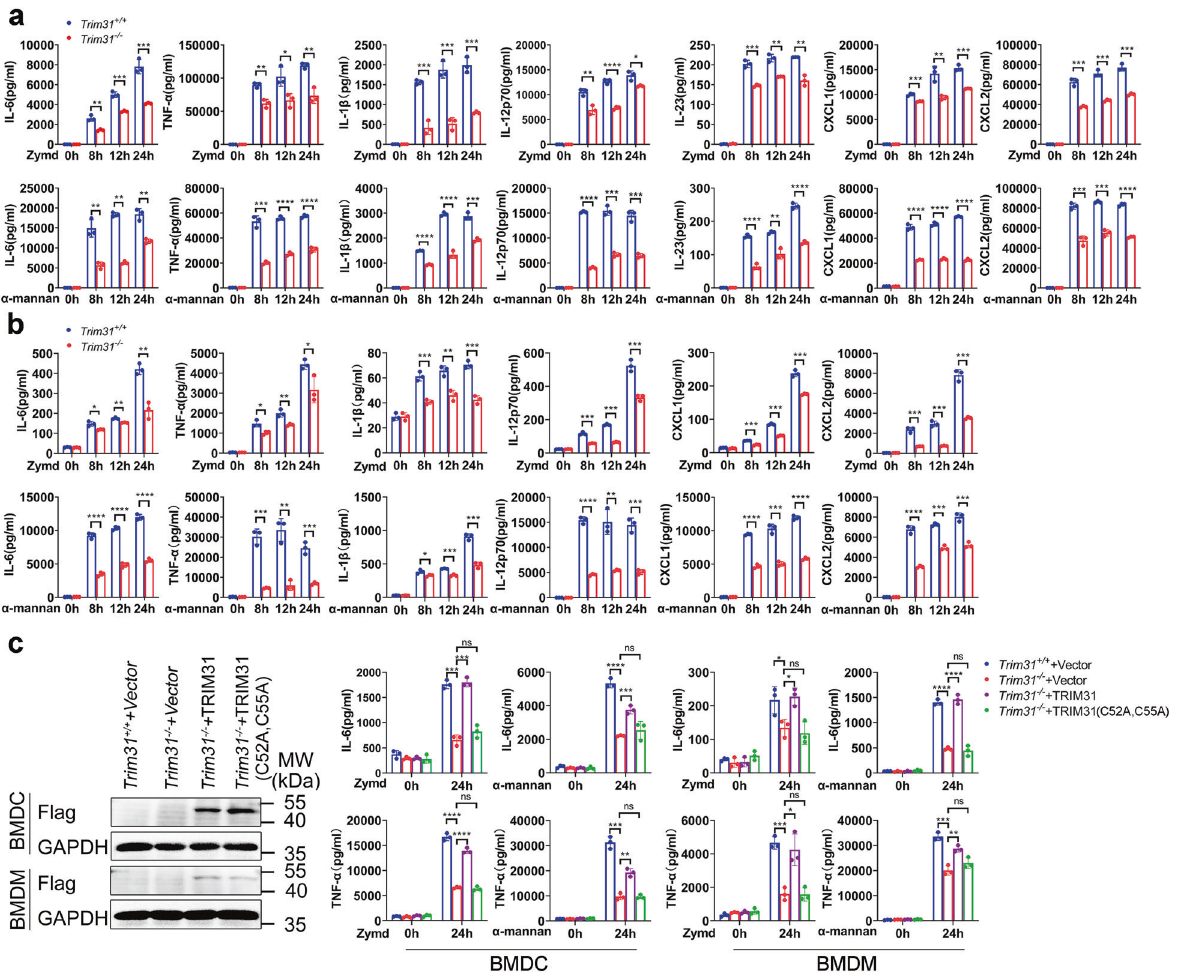
Fig. 4 TRIM31 controls antifungal activities of BMDCs and BMDMs. a ELISA analysis of IL-6, TNF- α , IL-1 β , IL-12, IL-23, CXCL1, and CXCL2 in supernatants of Trim31 + / + and Trim31 − / − in BMDCs stimulated with Zymd (100 µg/ml) and α -mannan (100 µg/ml) for the indicated time points. b ELISA analysis of IL-6, TNF- α , IL-1 β , IL-12, CXCL1, and CXCL2 in supernatants of Trim31 + / + and Trim31 − / − in BMDMs stimulated with Zymd and α -mannan for the indicated time points. The ligands and concentrations are the same as ( a ). c Immunoblot analysis of the protein expression of TRIM31 in Trim31 − / − BMDCs and BMDMs transduced as in right (left). ELISA analysis of IL-6 (upper) and TNF- α (lower) in supernatants of Trim31 + / + and Trim31 − / − in BMDCs and BMDMs, respectively, transduced by lentiviral vector GV492, GV492-mTRIM31, and GV492-mTRIM31 (C52A, C55A) followed by stimulation with Zymd and α -mannan for 0 – 24 h (right). * P < 0.05; ** P < 0.01; *** P < 0.001; and **** P < 0.0001 (Student ’ s t -test in a – c ). Experiments were done in triplicates (mean ± s.d. in a – c